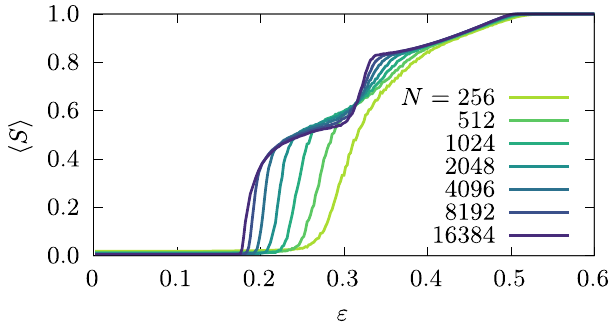
Fig. 3 Behaviour of the mean relative size of the largest cluster for the Erd ő s – Rényi hypergraph with high connectivity c . Mean relative size of the largest cluster h S i as a function of the con fi dence ε for the HOID model on six-uniform ER hypergraphs with an expected mean degree of c = 150 for different system sizes.